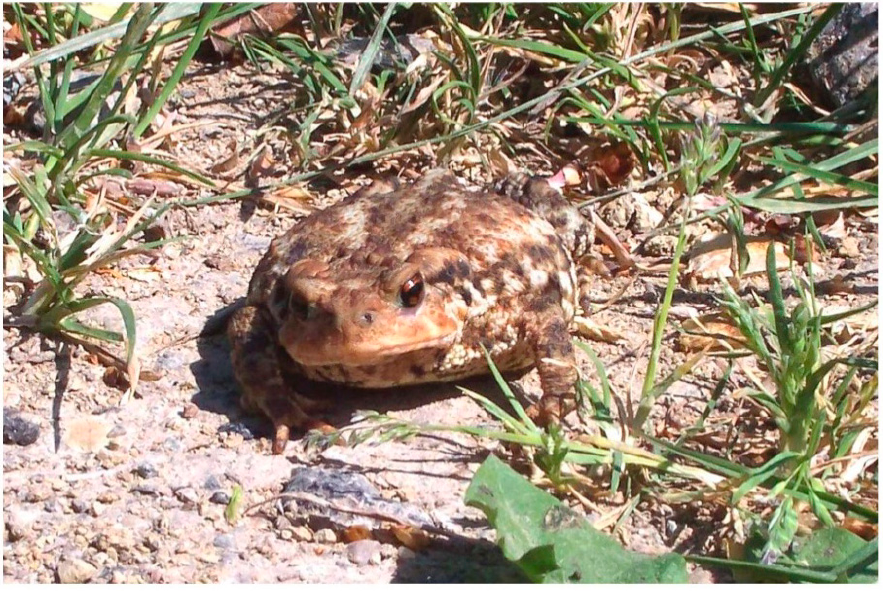
Figure 1. Example of a B. spinosis